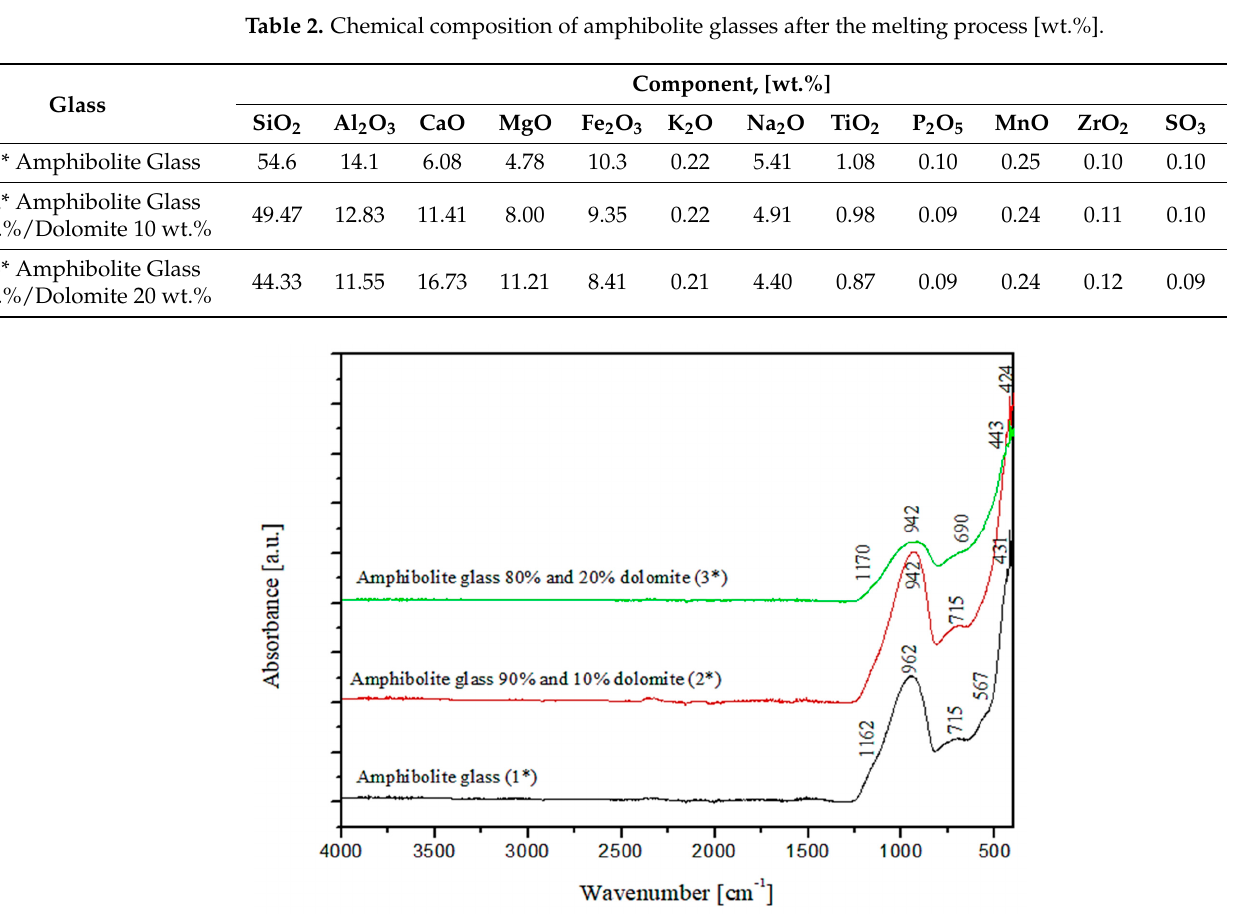
Figure 3. FTIR spectra of amphibolite glasses after the melting process.